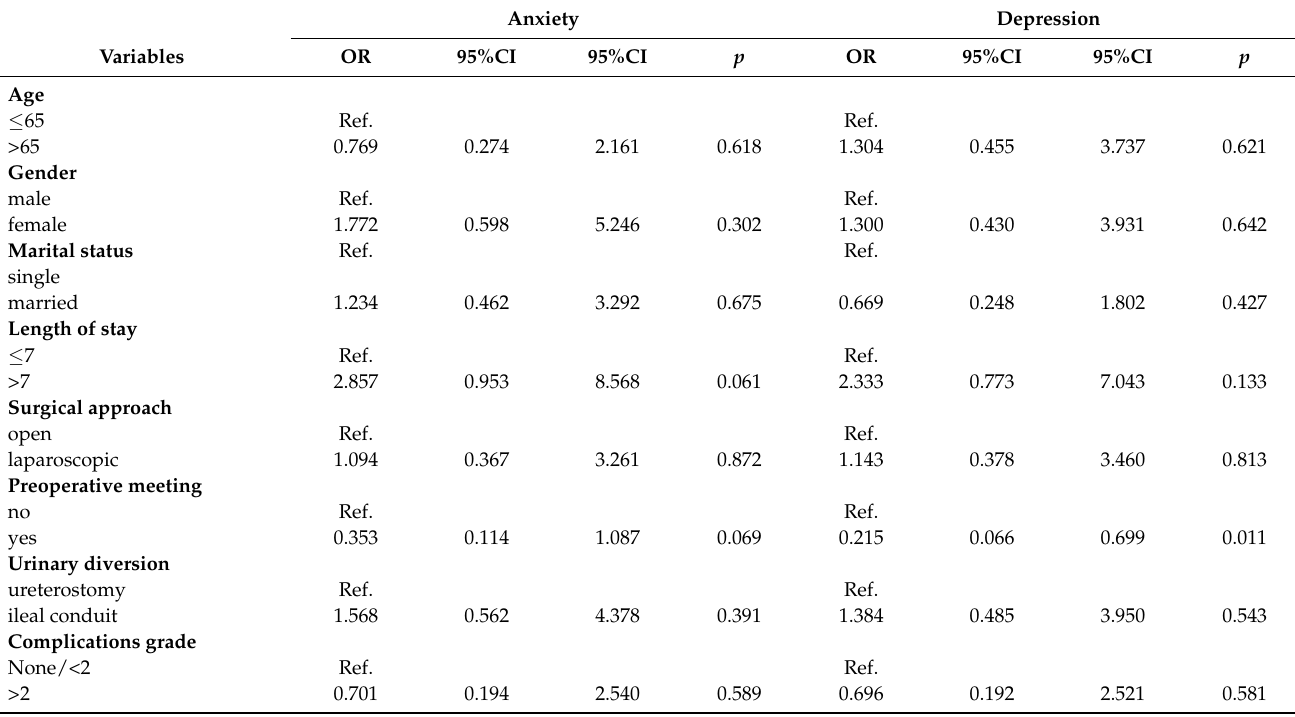
Table 3. Analysis of clinical factors associated with borderline or abnormal postoperative feelings of anxiety and depression in HADS (generalized nonlinear model, multivariate logistic